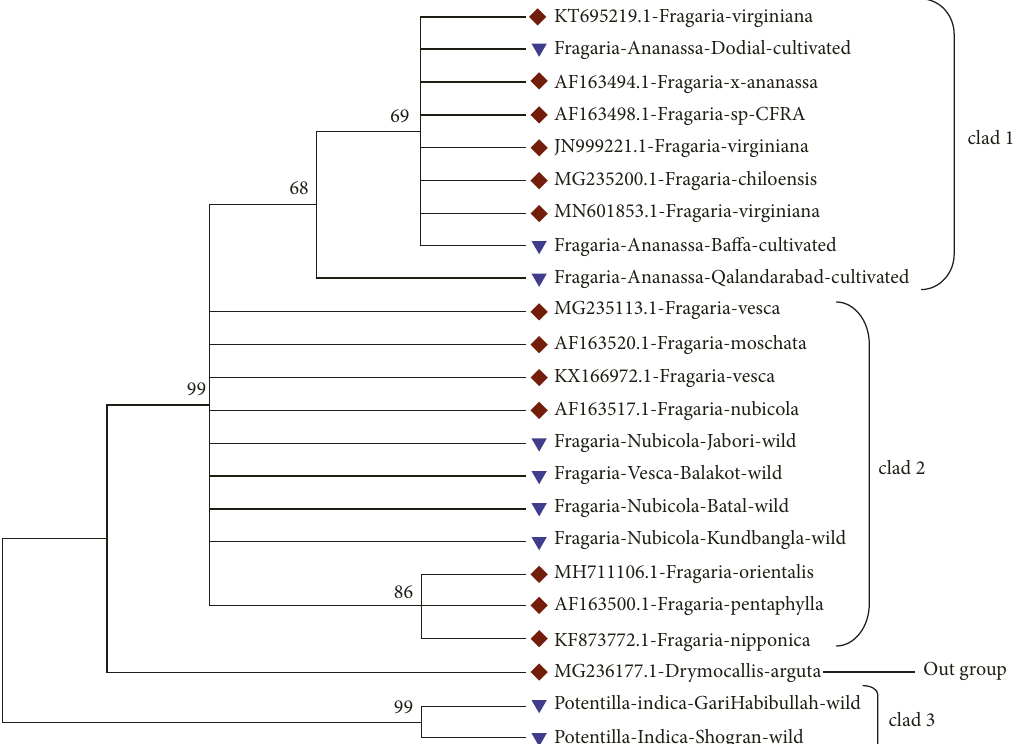
Figure 11: Phylogenetic tree of Fragaria species of ( ITS2 ) with related reference Fragaria species through the maximum likelihood